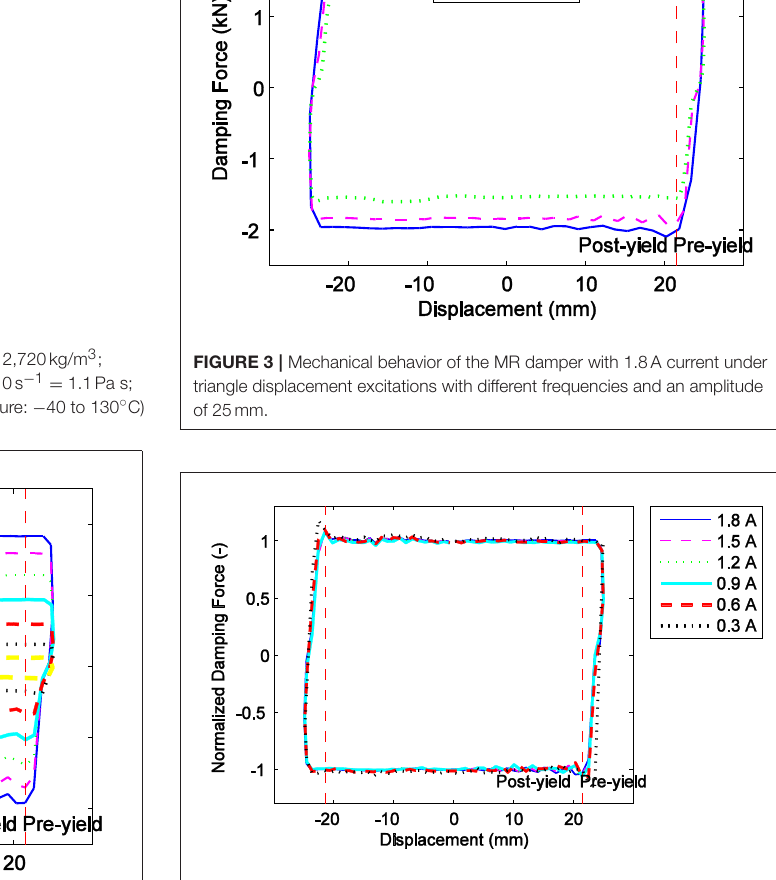
FIGURE 4 | Normalized force-displacement plot of the MR damper with different currents under triangle displacement excitation with a frequency of 1Hz and an amplitude of